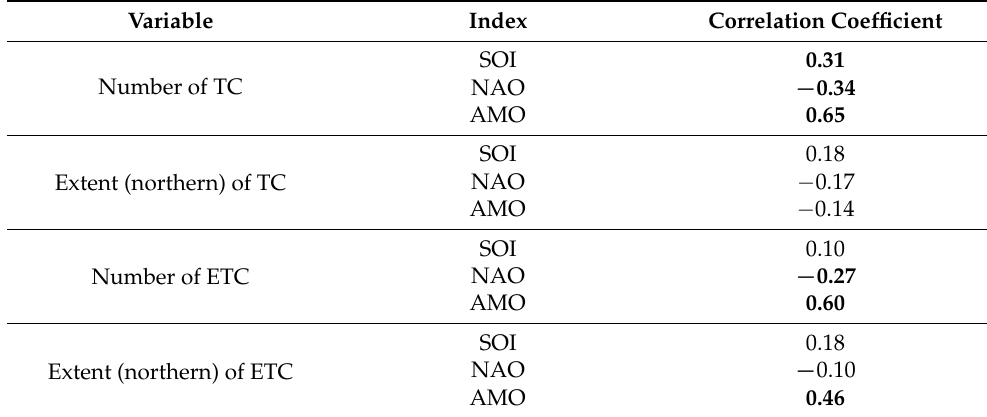
Table 1. Correlation coefficients between the annual number and maximum annual extent of TC and ETC and the SOI, NAO and AMO index values. In bold, statistically significant results at the significance level α < 0.05 are shown. Index Correlation Coefficient SOI 0.31 Number of TC NAO AMO